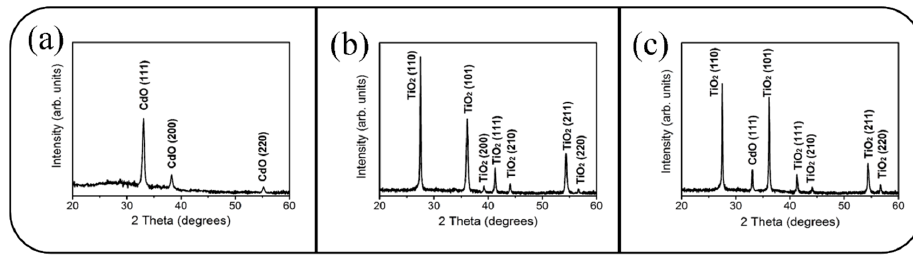
Figure 2. ( a ) XRD pattern of the CdO film. ( b ) XRD pattern of the TiO 2 rods. ( c ) XRD pattern of the TiO 2 –CdO rods.